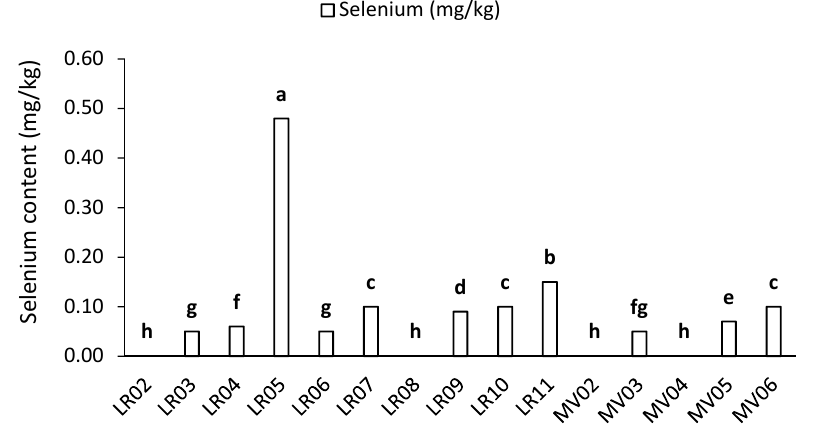
Figure 4. Se contents of landraces and modern varieties. Means followed by the same lower-case letters are not significantly different (DMRT; p < 0.05).